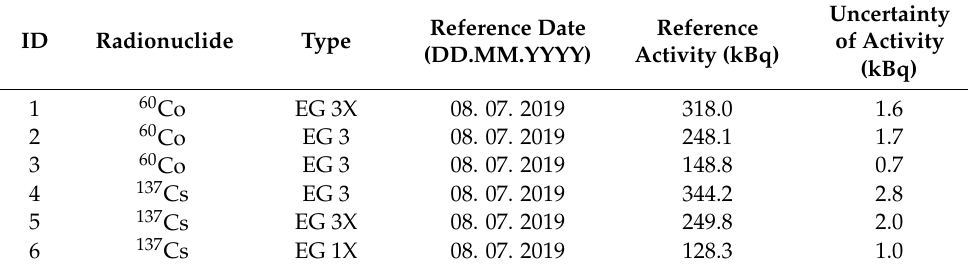
Table 4. The list and the parameters of ionising sources used for experimental